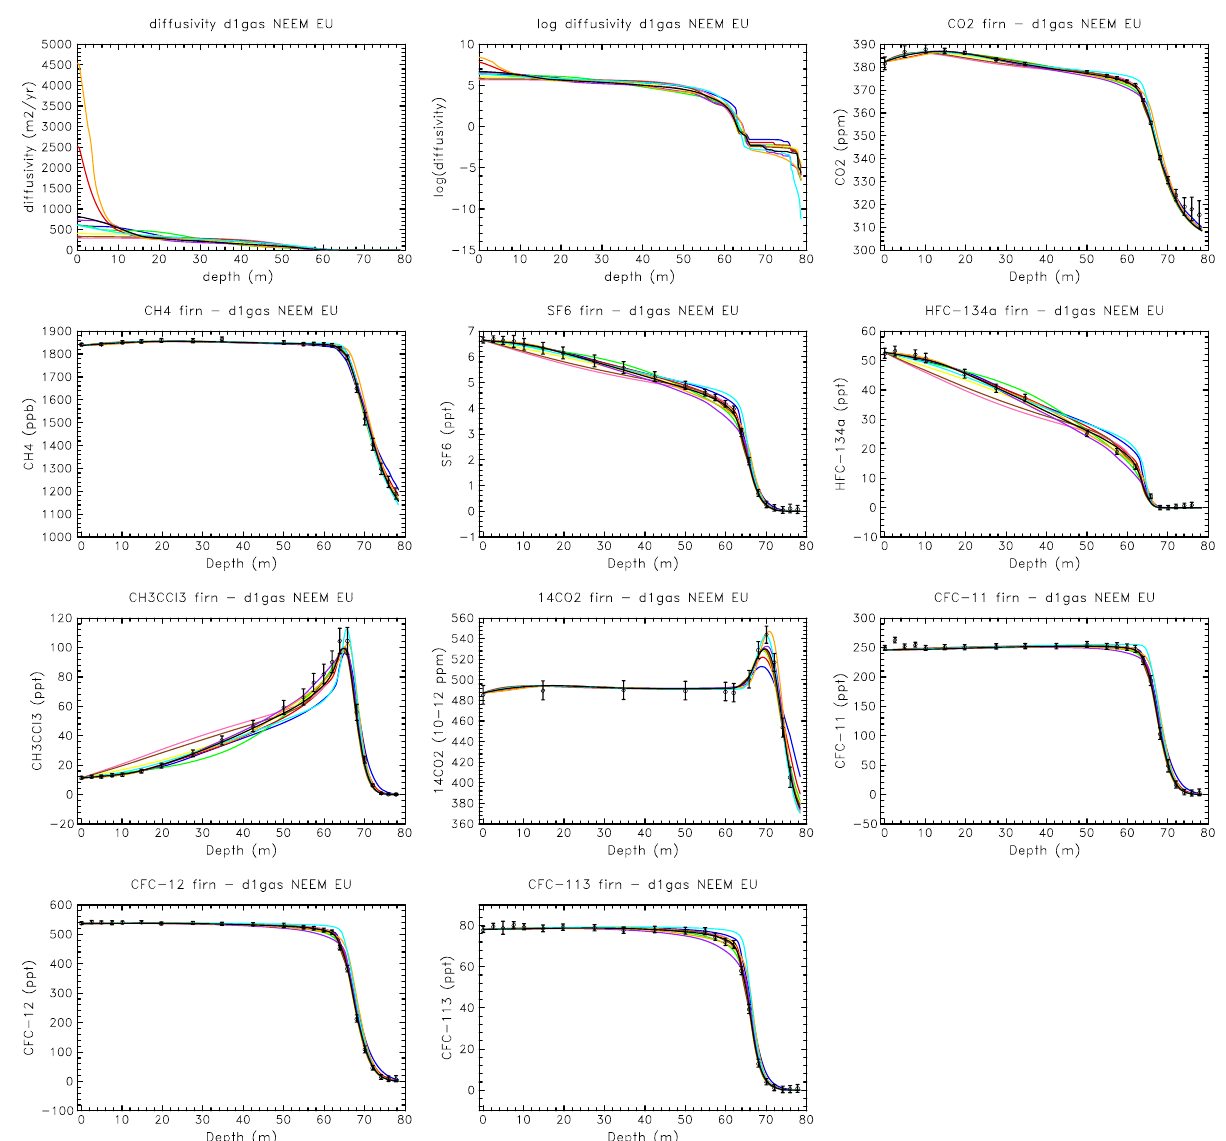
Fig. 5. Single gas inverse diffusivity model for NEEM (EU hole): each gas is used in turn to compute the diffusivity (reduced to CO 2 ). Results for CO 2 (blue), CH 4 (green), SF 6 (red), HFC-134a (orange), CH 3 CCl 3 (violet), 14 CO 2 (turquoise), CFC-11 (pink), CFC-12 (yellow), CFC- 113 (brown) and with the 9 gases (black,